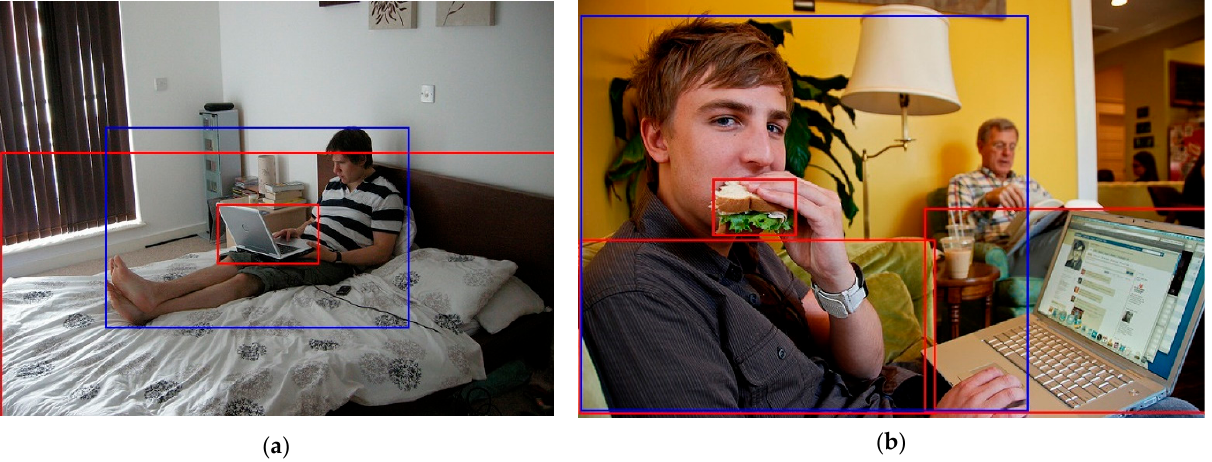
Figure 5. Examples of annotations in the dataset with a human doing multiple actions at the same time: ( a ) person lying on the bed and working on a computer and ( b ) person sitting on a chair, eating a sandwich and working on a computer